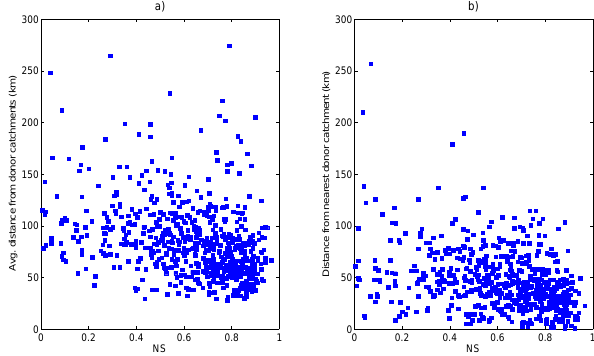
Fig. 4. Relationship of Nash Sutcliffe efficiency (NS) with (a) aver- age distance from donor catchments, and (b) distance from nearest donor